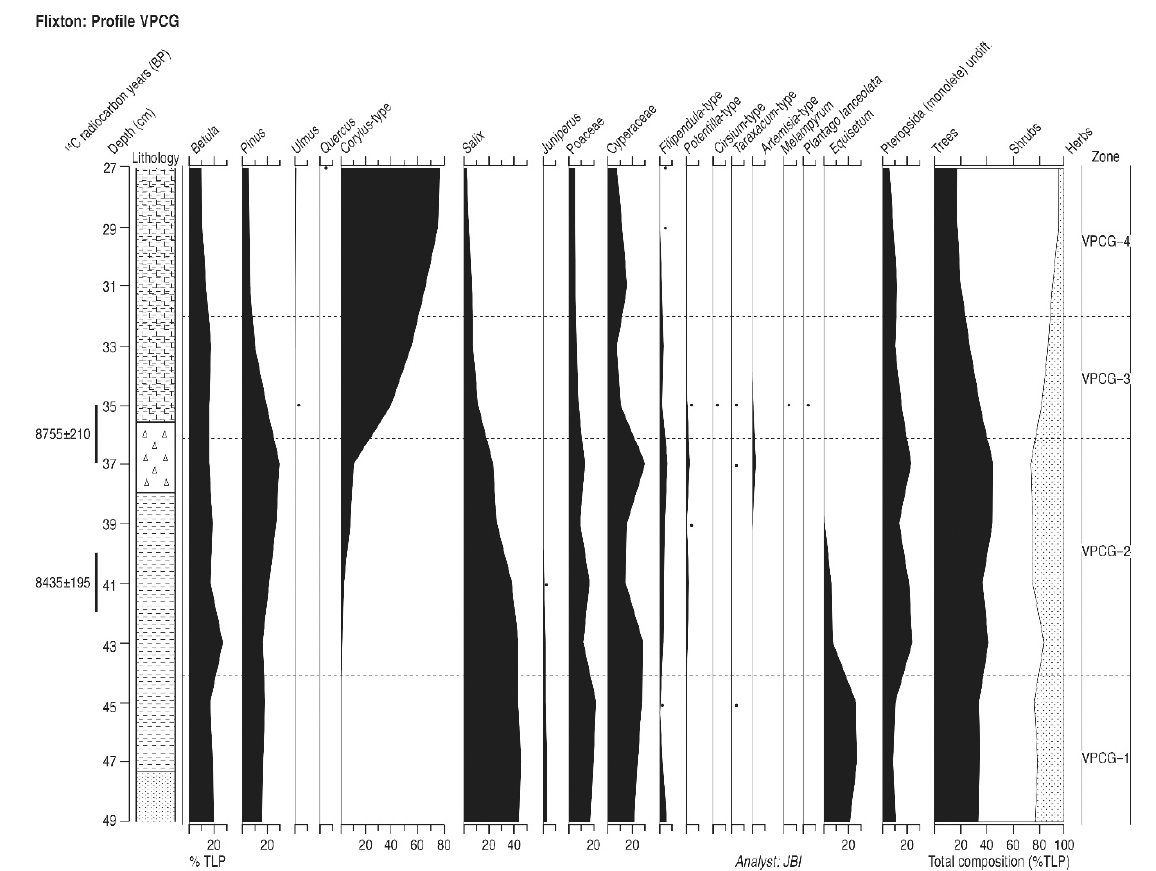
Figure 8. Percentage pollen diagram from Flixton profile VPCG. (Analysis JBI).